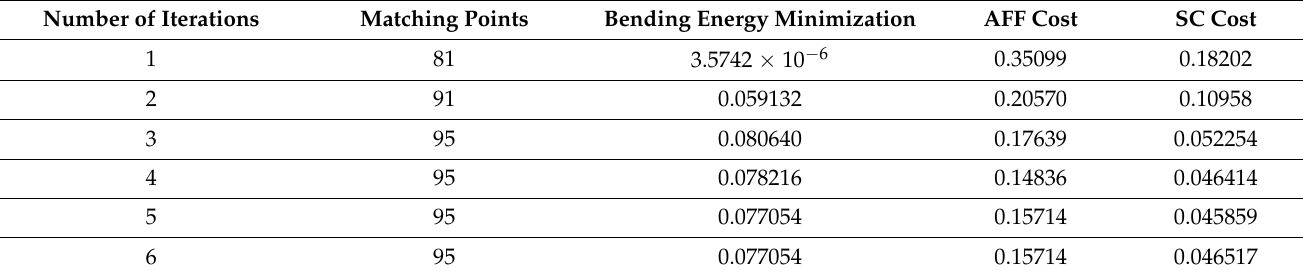
Table 1. Comparison of the variable value of iteration process.